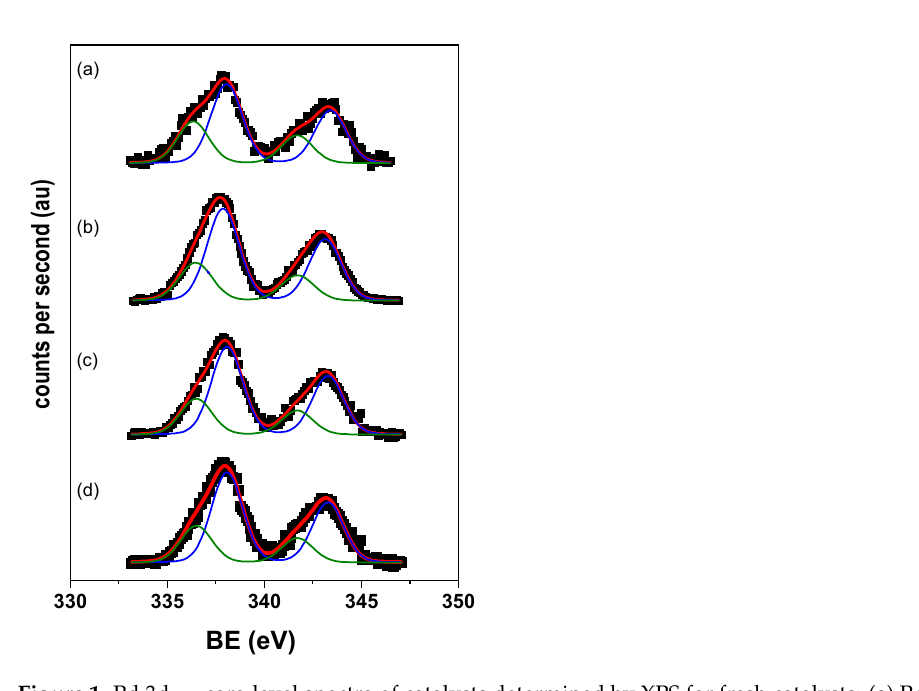
Figure 1. Pd 3d 5/2 core-level spectra of catalysts determined by XPS for fresh catalysts: ( a ) Pd/SO 3 H-Br-10, ( b ) Pd/SO 3 H-Br-20, ( c ) Pd/SO 3 H-Br-40, and ( d ) Pd/SO 3 H-Br-50. Table 3. Binding energy (eV) of Pd 3d 5/2 core levels for prepared catalysts (the relative proportion of each peak is given in parenthesis).